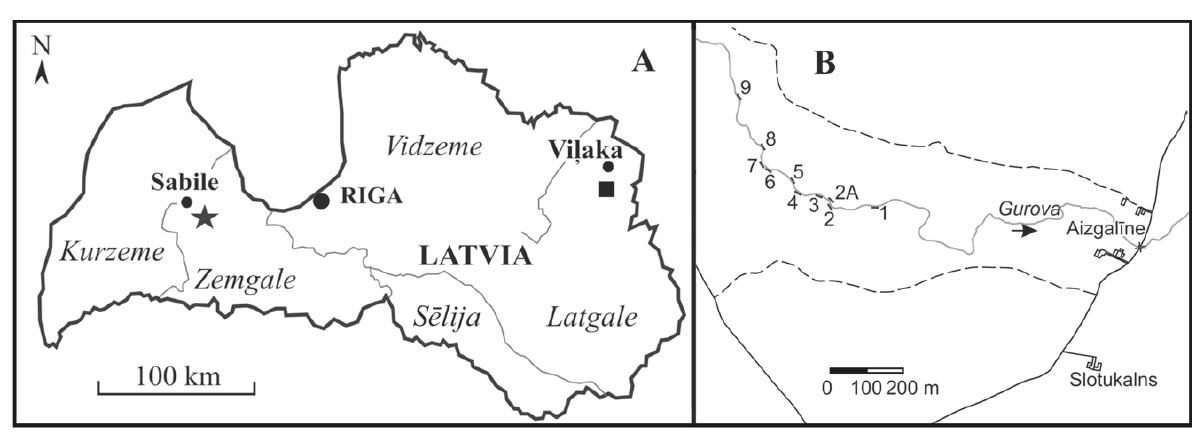
Fig. 2. A , location of the studied outcrops (black rectangle) and the Langsēde site (black star) relative to the area of Latvia; B (corresponds to the black rectangle in A), studied sections and their numbers in the vicinity of